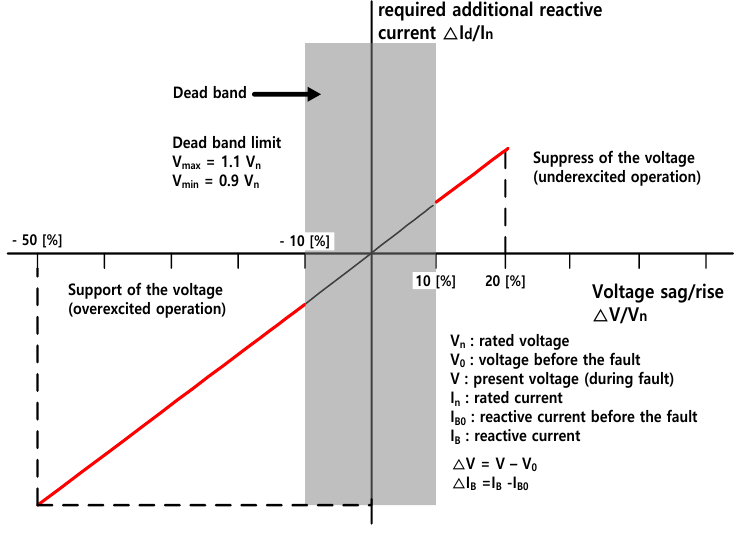
Figure 2. Reactive current support